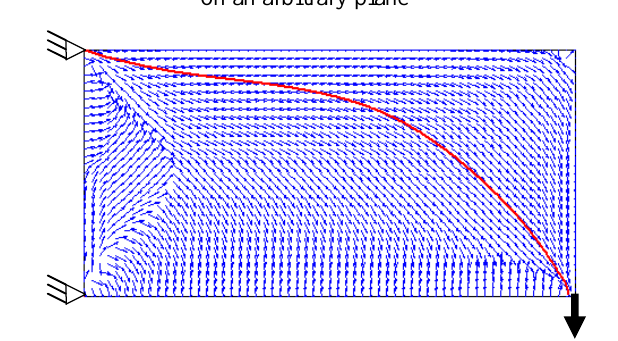
Fig 1. Geometry and notation for stress components acting on an arbitrary